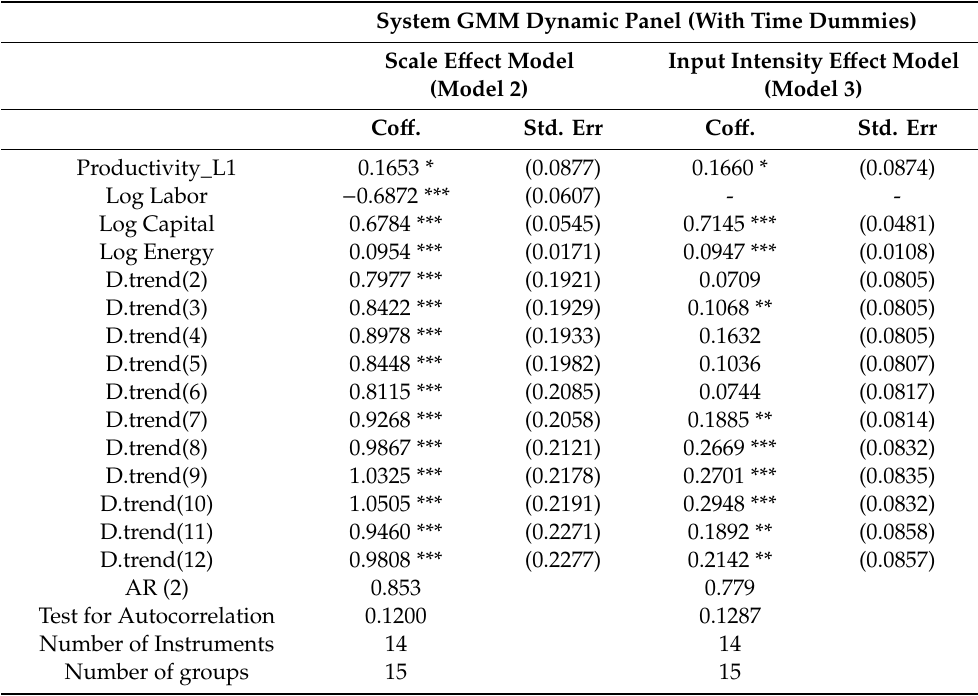
Table 7. System GMM dynamic panel with time dummies for Models 2 and